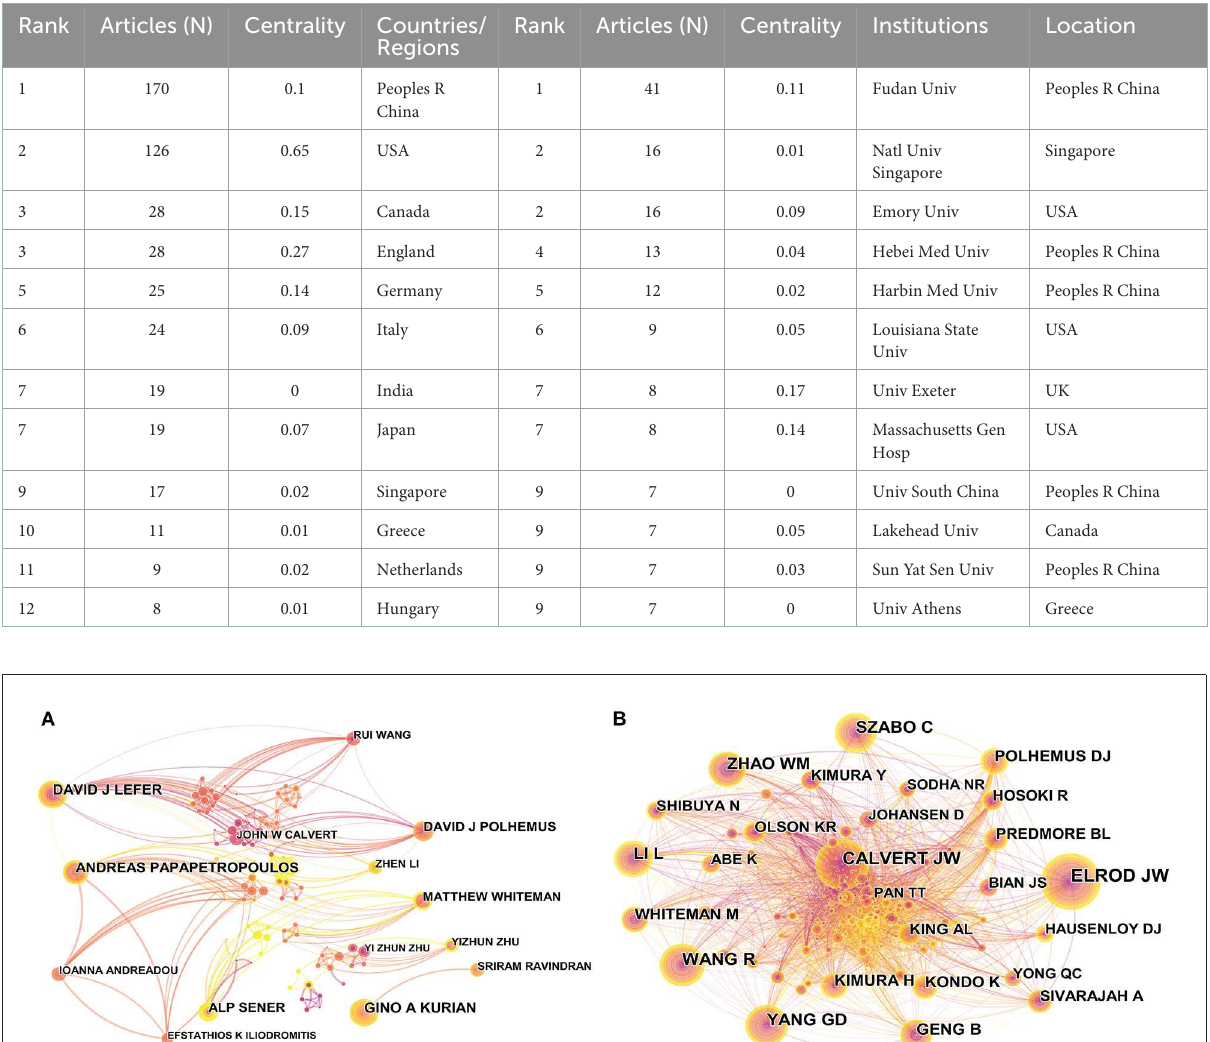
TABLE 1 Top 12 productive country/regions and institutions related to hydrogen sulfide in heart preservation research. Rank